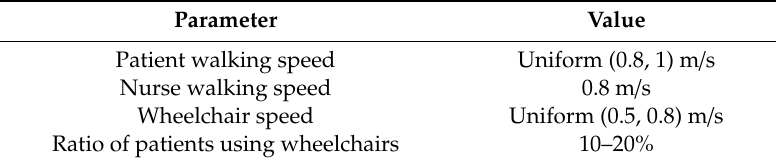
Table 3. Simulation parameters for the regular process.